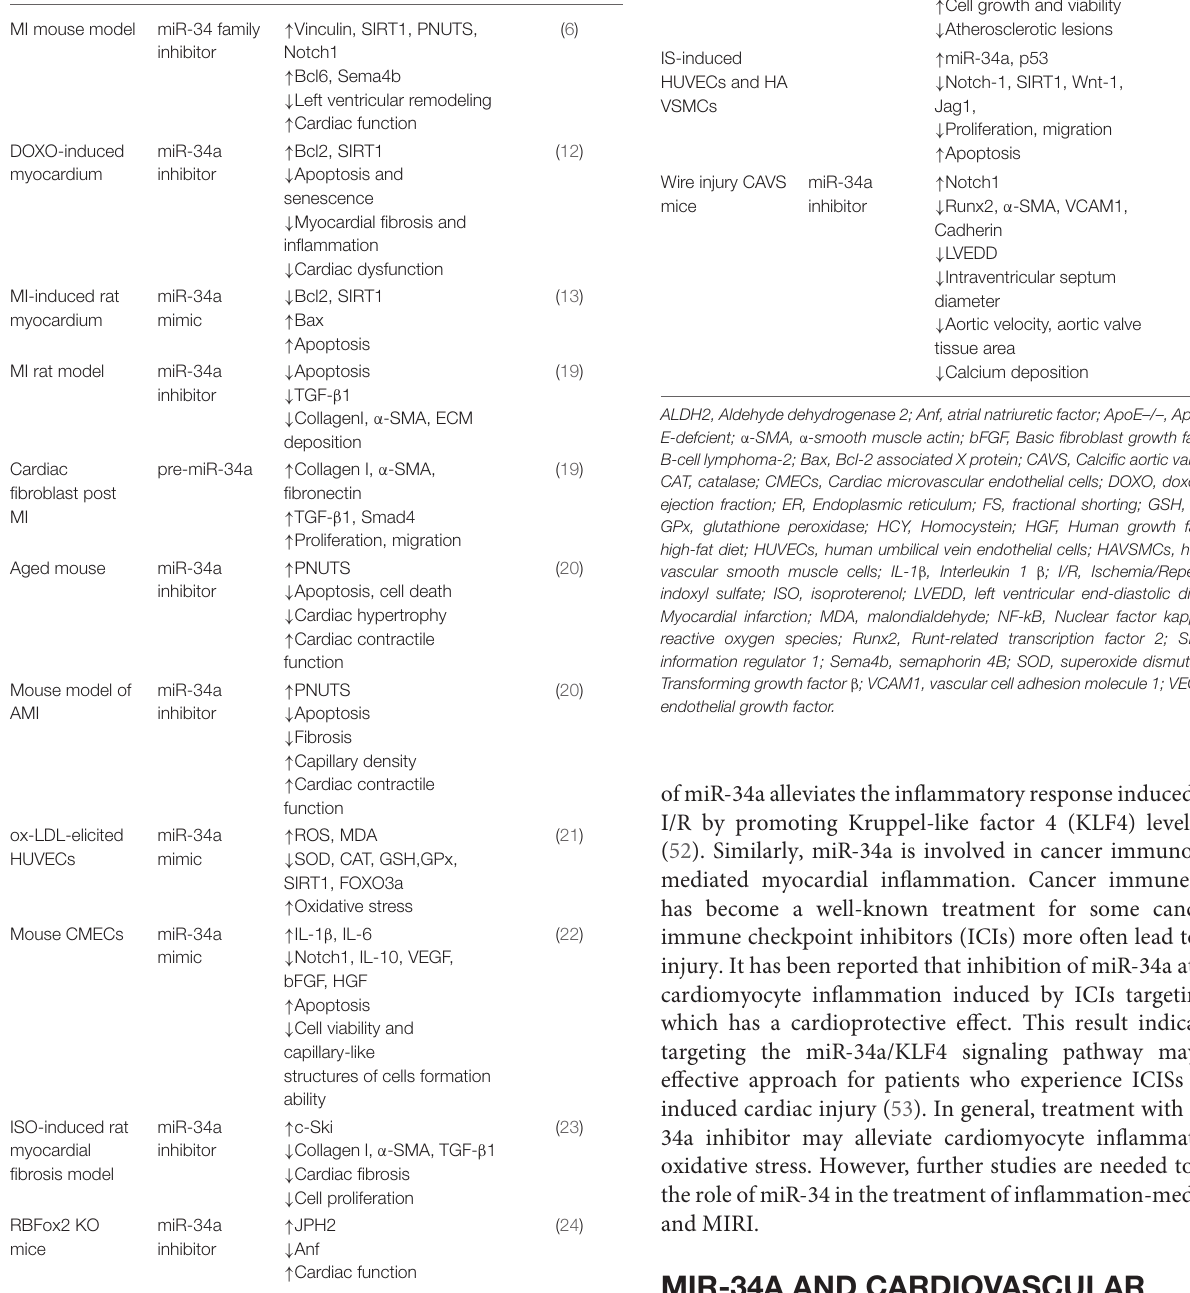
TABLE 1 | The regulatory roles and underlying mechanisms of miR-34a in cardiovascular dysfunction and disorders. Experimental